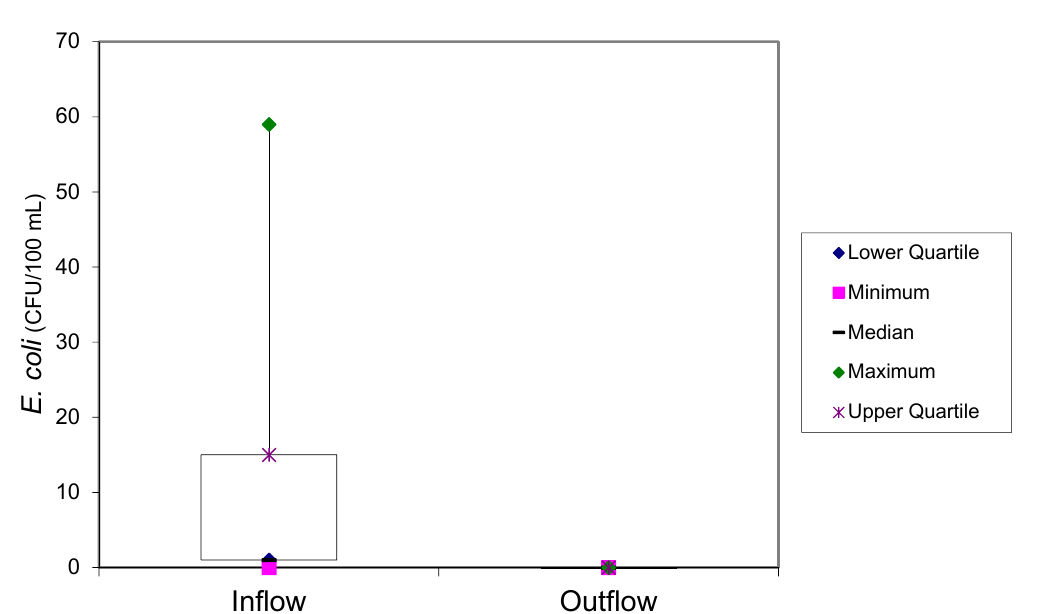
Figure 6. Box and whisker plot highlighting differences in inflow (n = 390) and outflow (n = 390) of E. coli count. for the silver nitrate filters.